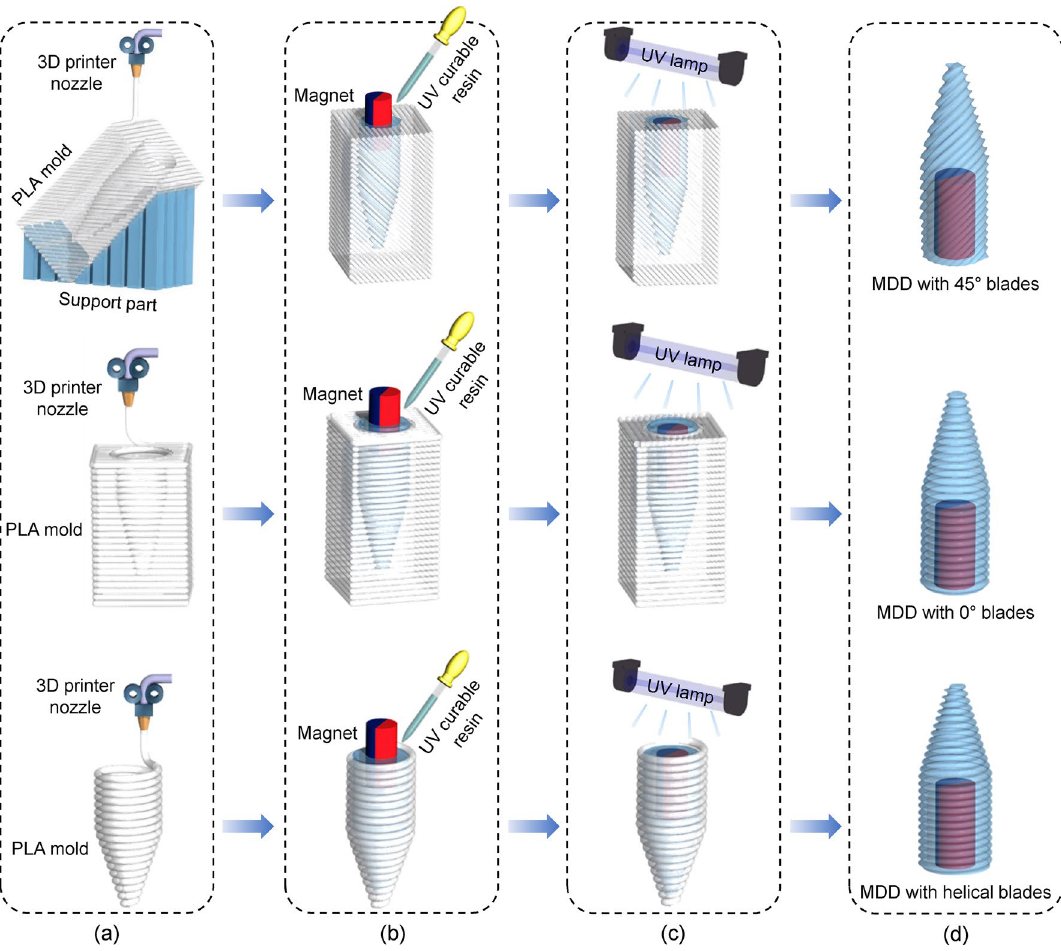
Figure 2. Overall fabrication process to manufacture MDDs with 45°-tilted, 0°, and helical blades. ( a ) 3D printing the PLA casting mold using FFF-type 3D printer; ( b ) Pouring the UV curable resin into the casting mold followed by degassing process, and inserting the neodymium magnet; ( c ) Curing the resin using UV lamp; ( d ) Separating the MDD from the casting mold by soaking in acetone.